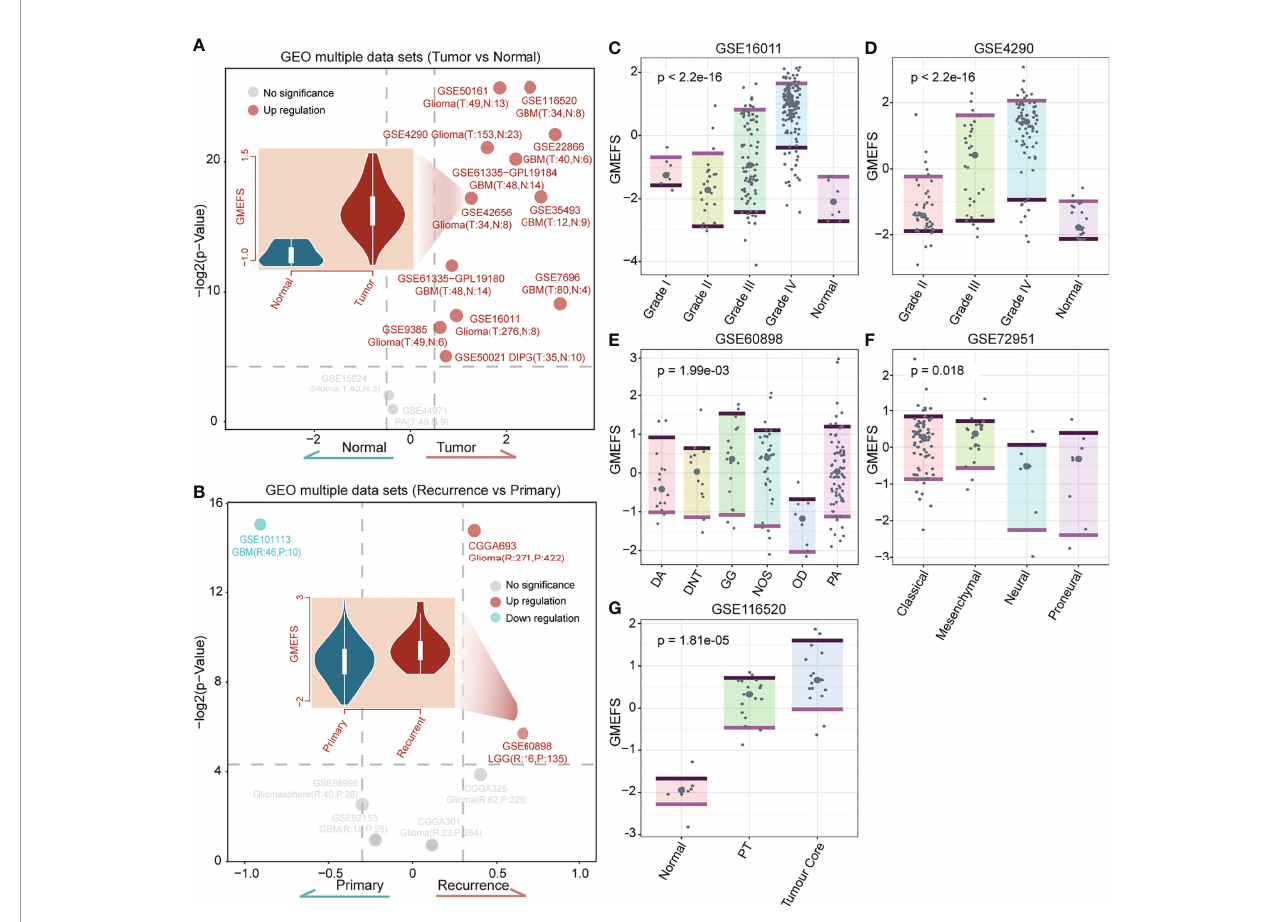
FIGURE 5 | The con fi rmation of the GMEFS in glioma formation and recurrence. (A) Volcano plot of the GMEFS score between the two types of samples within each dataset for the tumor vs. normal conditions. (B) Volcano plot of GMEFS score between the two types of samples within each dataset for the recurrence vs. primary condition. Boxplot illustrating the distribution of the GMEFS score in different clinical information including clinical stage: (C) GSE16011, (D) GSE4290; molecular subtypes: (E) GSE60898, (F) GSE72951; and tumor regions: (G)